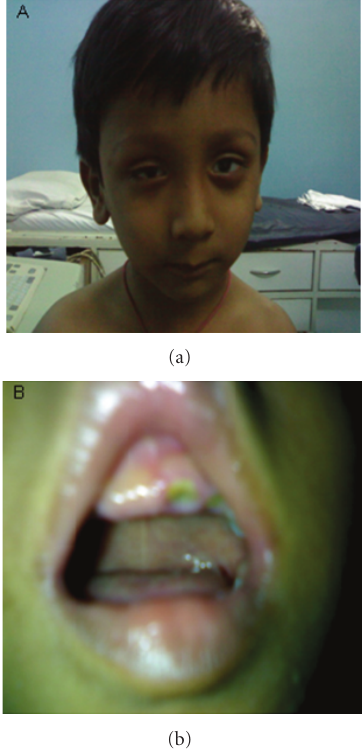
Figure 2: Facial feature of Case 2, (a) showing facial dysmorphism and (b) high arched palate and dental carries.